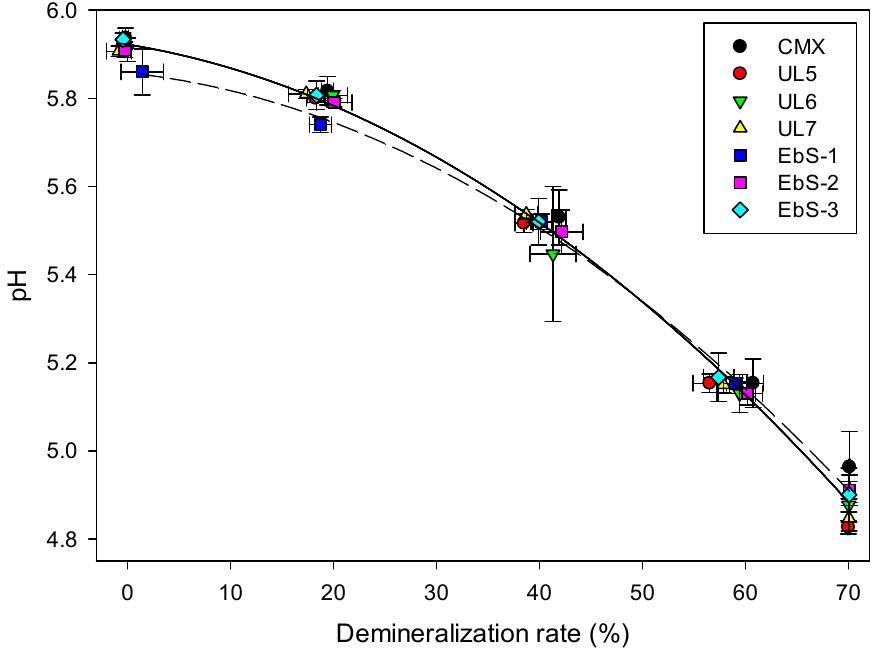
Figure 6. pH evolution of whey during electrodialysis as a function of demineralization rate with hCEMs or CMX.